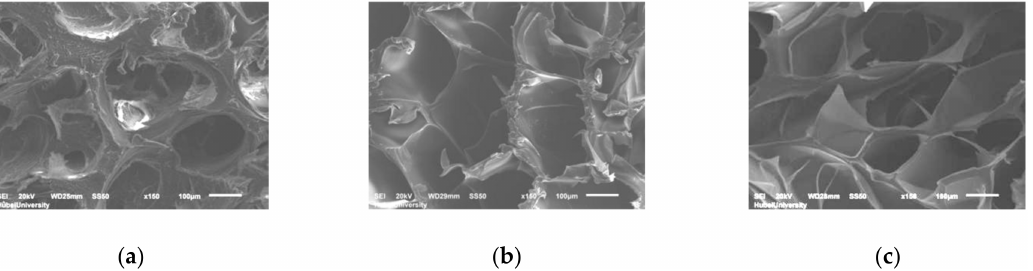
Figure 6. Scanning electron microscope (SEM) images of Gel ( a ), GGel ( b ), and CGGel ( c ) hydrogels. Bars represent 100 µ